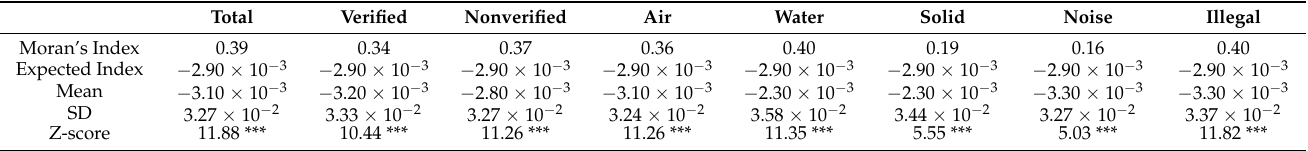
Table 1. The Global Moran Index of environmental complaints in